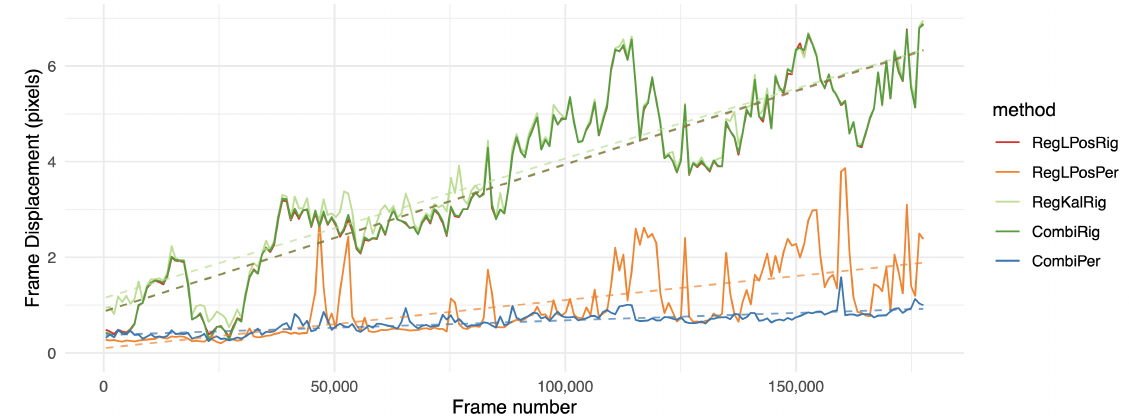
Figure 7. Frame displacement ( fd ) indicator over time on the two hours long L2 sequence. The lower the position on the graph, the better. Values were aggregated by averaging on intervals of approximately 1000 frames. For more clarity, we left out the less relevant methods. The dashed line shows the result of a linear regression over the whole